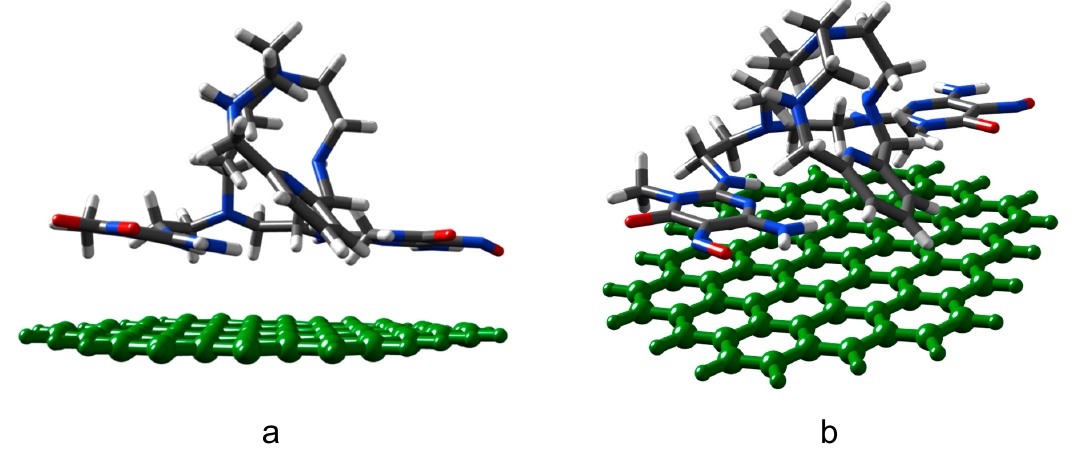
Molecules 2019 , 24 , x FOR PEER REVIEW Figure 7. ( a ) Plot of surface charge density values of G-(H 2 L) ( Q in mmol of H + per gram) as a pH function and ( b ) profile of pKa values of the acidic of G-H 2 L as a pH function.